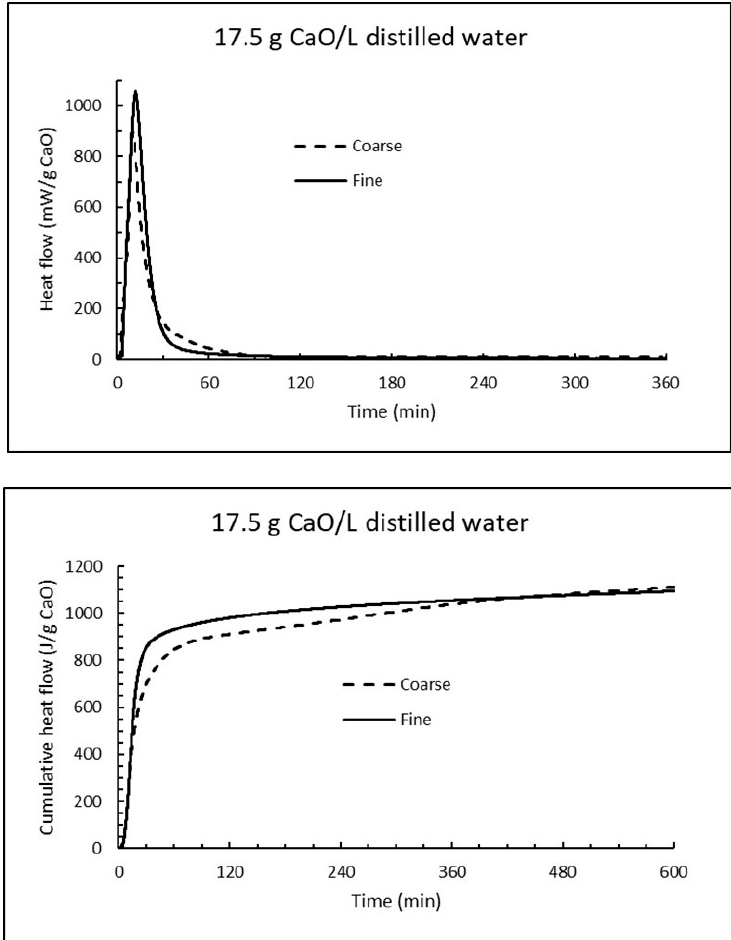
Figure 16. The heat flow ( top ) and cumulative heat ( bottom ) under isothermal conditions at 15 °C when 17.5 g CaO is mixed with 1 litre distilled water.